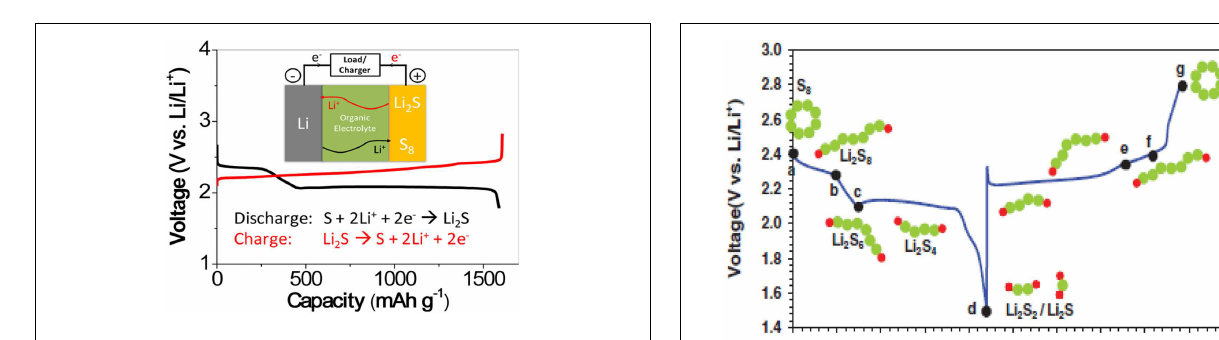
The low voltage plateau, which occurs between 1.9 and